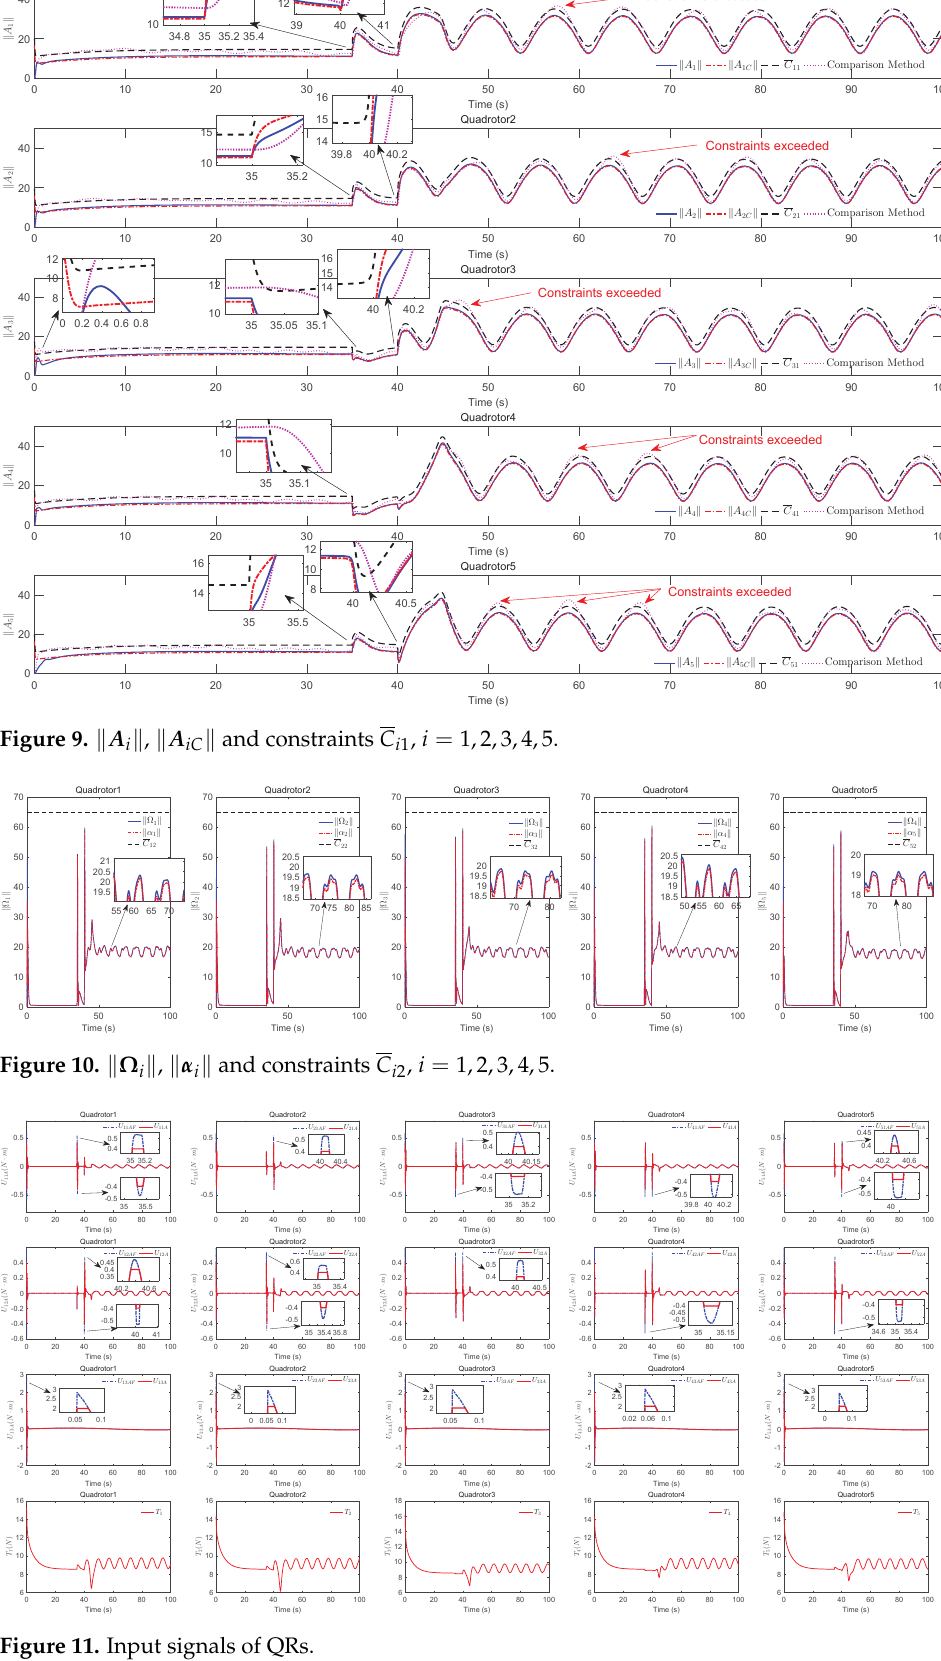
Figure 11. Input signals of